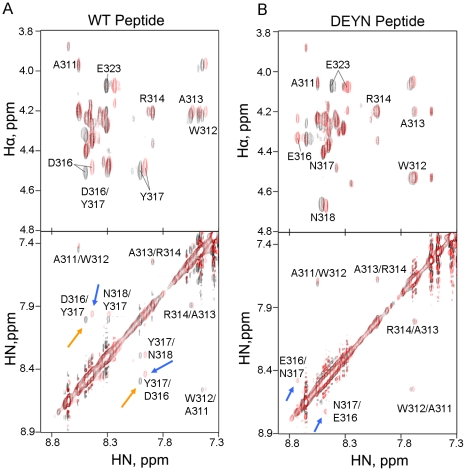
CyPA induces turn conformations in DEYN.Superposition of 400 ms NOESY spectra of (A) WT or (B) DEYN peptide in the absence (black) and presence (red) of CyPA at a 10∶1 peptide:protein ratio. HN-Hα (top) and HN-HN (bottom) correlations are shown for each sample. WT peptide exhibited sequential HN-Hα and HN-HN NOEs, indicating random coil ensemble of conformers. Addition of CyPA resulted in chemical shift changes but did not significantly alter the NOE pattern or intensities. In contrast, DEYN peptide lacked sequential HN-HN NOEs in D316-N318 in the absence of CyPA, indicating that the EN substitutions increased the population of extended conformers in this region relative to the WT peptide. Addition of CyPA also resulted in chemical shift changes in DEYN peptide and introduced a sequential HN-HN NOE between E316-N317 that is not seen in WT even at the lowest possible contour levels.